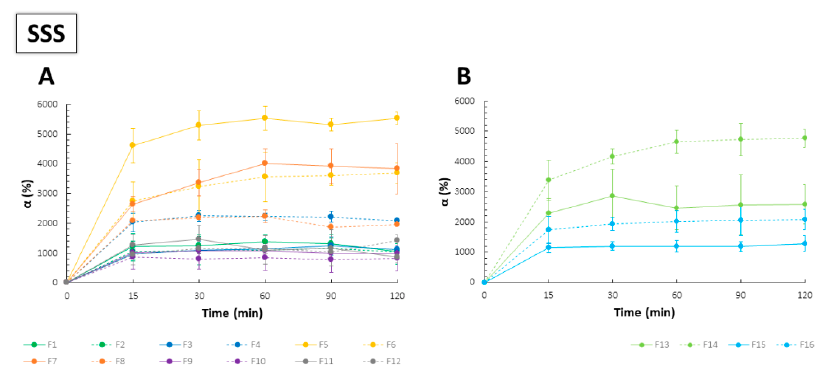
Figure 4. Swelling behavior of F1–F12 ( A ) and F13–F16 ( B ) films in the simulated saliva solution (SSS) (mean ± SD, n = 3). (mean ± SD, n =